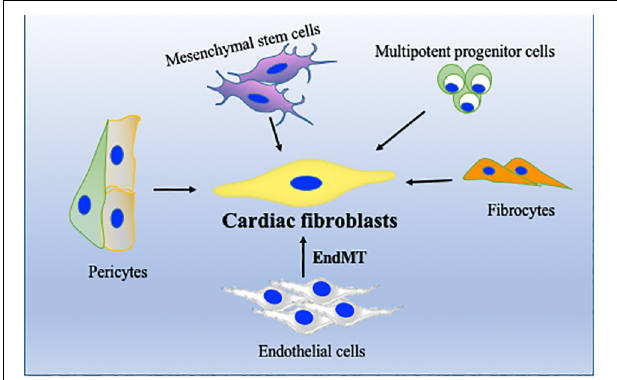
FIGURE 2 | Cellular sources of cardiac fibroblasts (CFs). In addition to resident fibroblasts, CF can originate from endothelial cells, through endothelial-to-mesenchymal transition (EndMT), from bone marrow stem/progenitor cells, from perivascular cells or from fibrocytes. Their activation and differentiation to become activated fibroblasts/myofibroblasts are highly dependent on pathological stress on the heart.